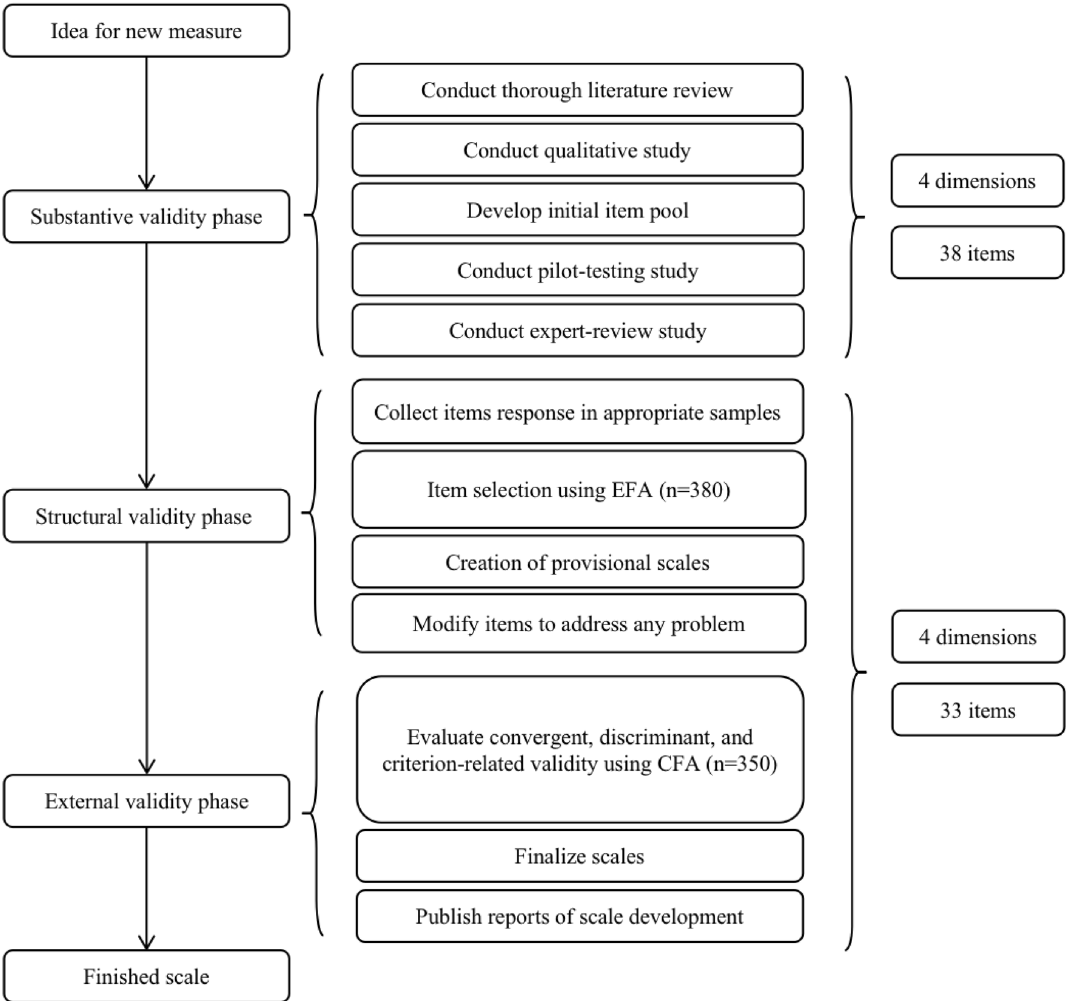
Figure 1. The instrument development and evaluation. PSSS, public stigma of stroke scale; EFA, exploratory factor analysis; CFA, confirmatory factor